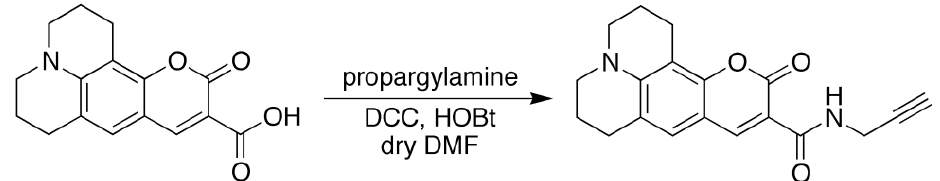
Figure 4. Synthesis of C343-pa.